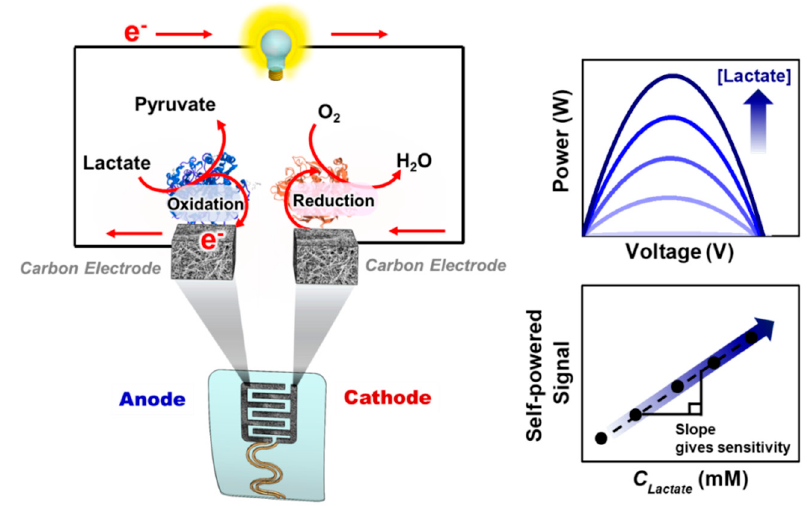
Figure 6. Conceptual illustration of a simple example of the application of BFC energy harvester for self-powered biosensors, such as lactate biosensing application.